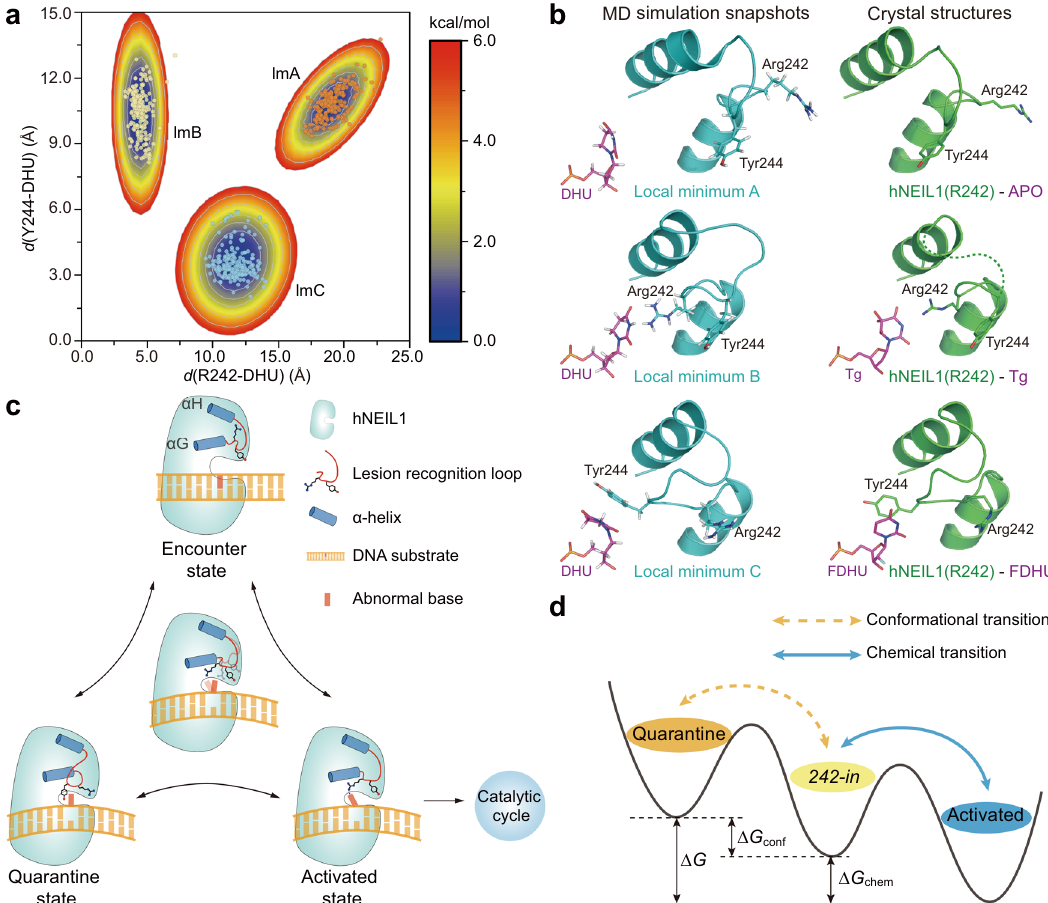
Fig. 3 A proposed nucleobase-recognition model of hNEIL1 by computational and structural evidences. a Adaptive MD simulations reveal the existence of three conformational states of hNEIL1 when interacting with the substrate DNA (DHU) with relatively enriched population. lmA local minimum A, lmB local minimum B, lmC local minimum C. The dots superimposed are randomly selected MD con fi gurations from each metastable conformation and colored accordingly. b The loop conformations of snapshots from adaptive molecular dynamics simulations are in good coincidence with those observed in the crystal structures. c Substrate-recognition model of hNEIL1. Upon encountering the DNA substrates, the lesion recognition loop of hNEIL1 shifts towards the fl ipped bases from the originally preferred apo conformation (Encounter state). Once the tautomerization-dependent hydrogen bond interaction between damaged base and residue 242 is established, the substrate would be activated (Activated state) and permitted to enter the catalysis cycle. Alternatively, if the base does not pass the chemical check, the loop would transit to a 244-in conformation (Quarantine state), temporally restricting the nucleobase from catalysis via competing with the activated state. d The relative dominance of the quarantine state and activated state depends on the tug of war between their thermodynamic stability. Δ G denotes free energy difference quantifying the relative stability of the activated state over the quarantine state. Δ G can be decomposed into two terms, Δ G conf (Supplementary Fig. 9) and Δ G chem , respectively. The gold dashed line represents a process involving conformational transition and the blue solid line means a chemical